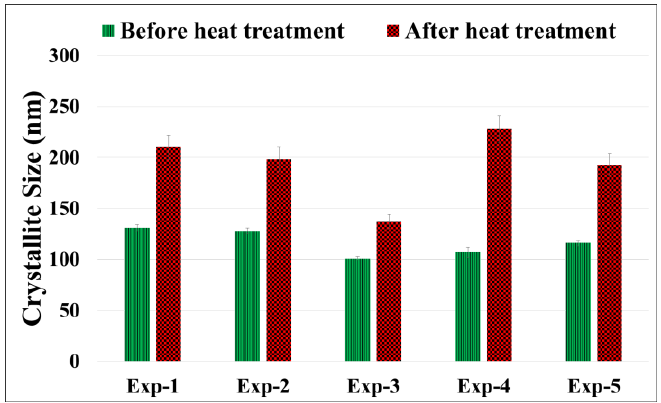
Figure 9. Crystallite size measured by XRD for all coatings before and after heat treatment.